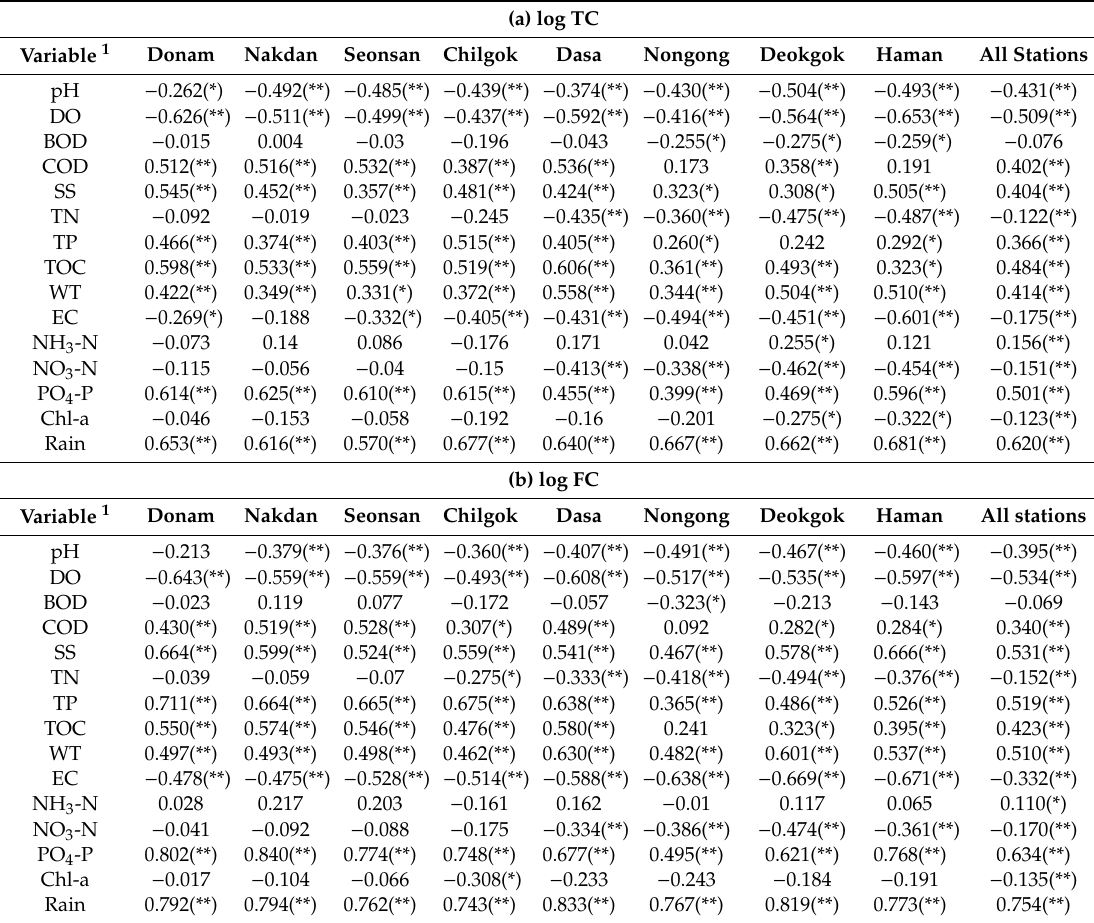
Table 2. Pearson correlation coe ffi cients (r) between total (a) and fecal (b) coliforms and water quality components at each weir station. One asterisk (*) and two asterisks (**) mean p < 0.05 and p < 0.01,